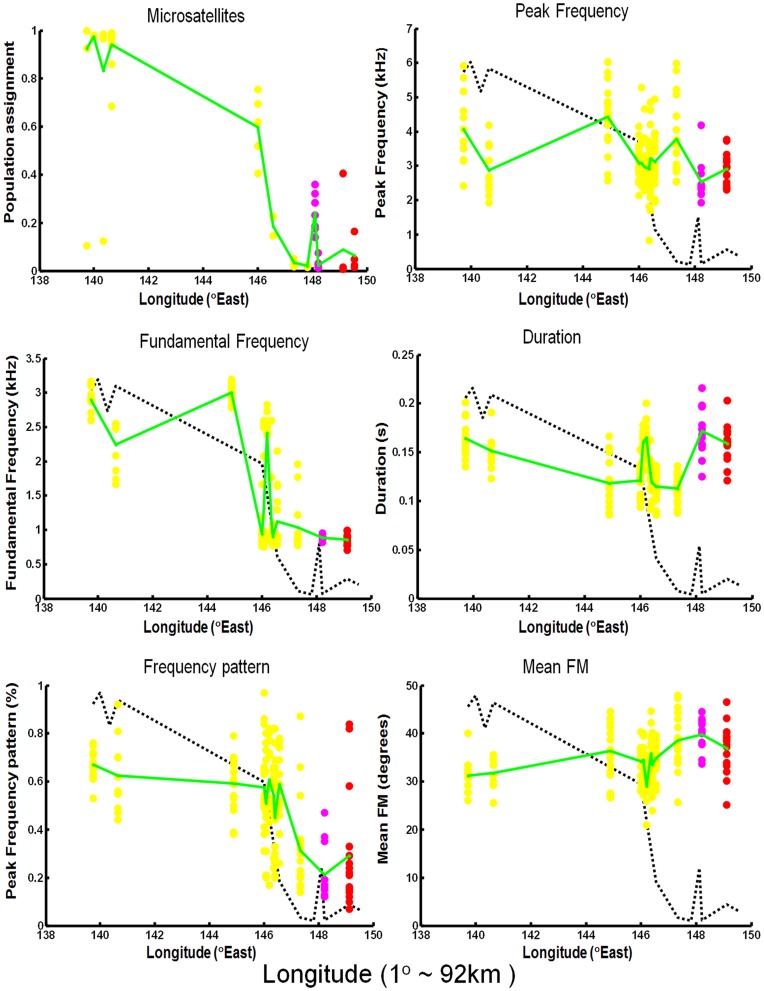
Plots of the microsatellite population assignment (using STRUCTURE) and all five acoustic variables clines.Dots are the mean values for each individual. The three plumage forms/subspecies are indicated by dot colour as follows: P. e. flaveolus, yellow dots; the Western Slopes population, purple dots; P. e. elegans, red dots. Green lines connect the means of each population, and the dotted line within the vocalization plots indicates the microsatellite cline for comparison. At this latitude 1 degree of longitude is roughly 92km, and the transect changes little with latitude (Fig. 1).